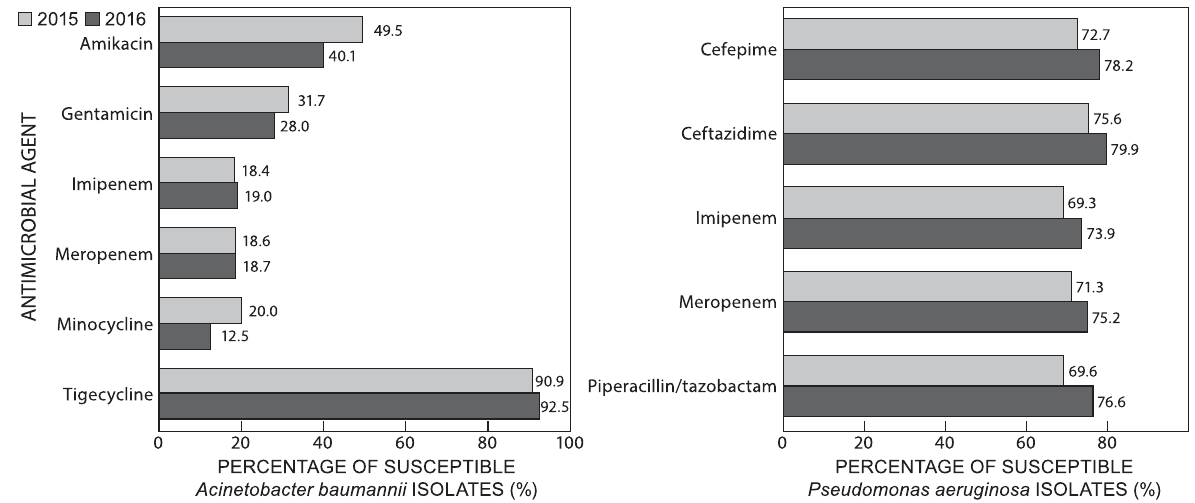
Figure 4: Percentage of susceptible Acinetobacter baumannii and Pseudomonas aeruginosa isolates, 2015 to